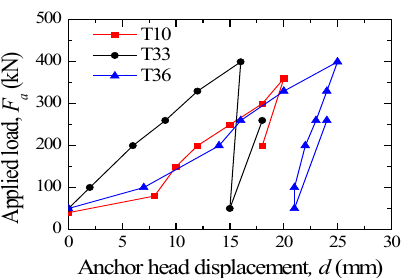
Figure 11 - Acceptance test results of anchors T10, T33 and